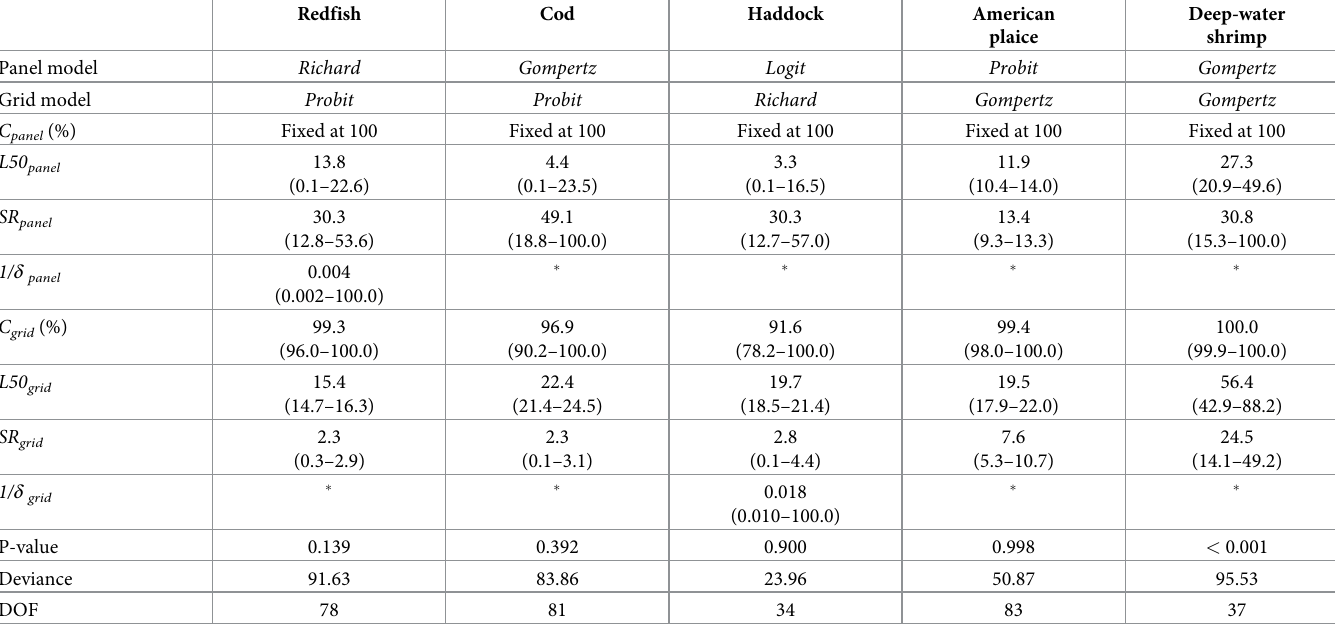
Table 2. Parameter values and fit statistics for the selected models. Values in parentheses are 95% confidence limits. Note that L50 and SR are provided in cm (total length) for the fish bycatch species and in mm (carapace length) for deep-water shrimp. � not in